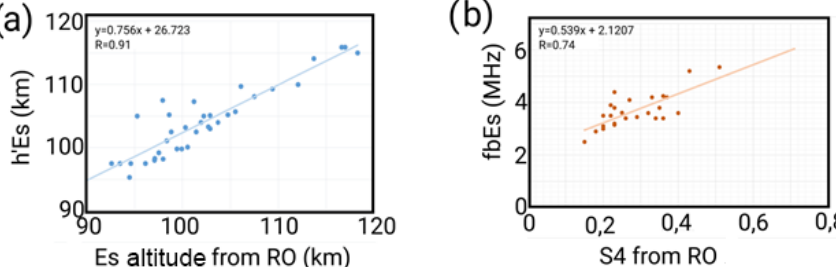
Figure 4. Comparison of sporadic E heights (a) and their intensity (b) obtained by radio occultation and ionosonde